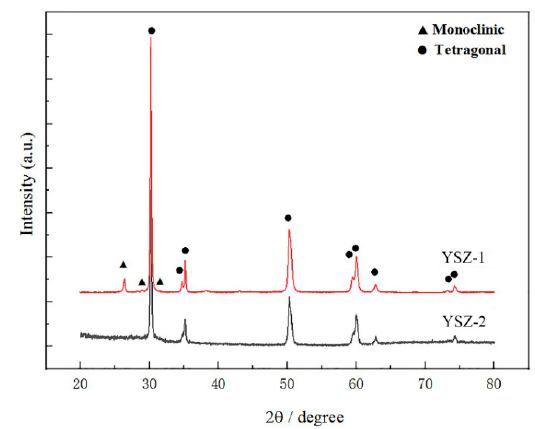
Figure 4. XRD patterns of the as-sprayed coatings YSZ-1 and YSZ-2.